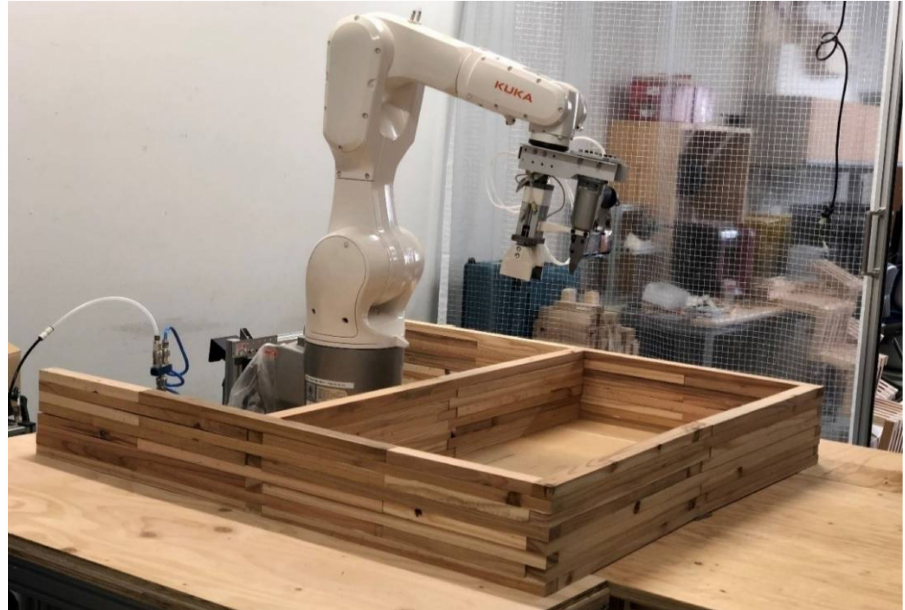
Figure 16. Robot construction site